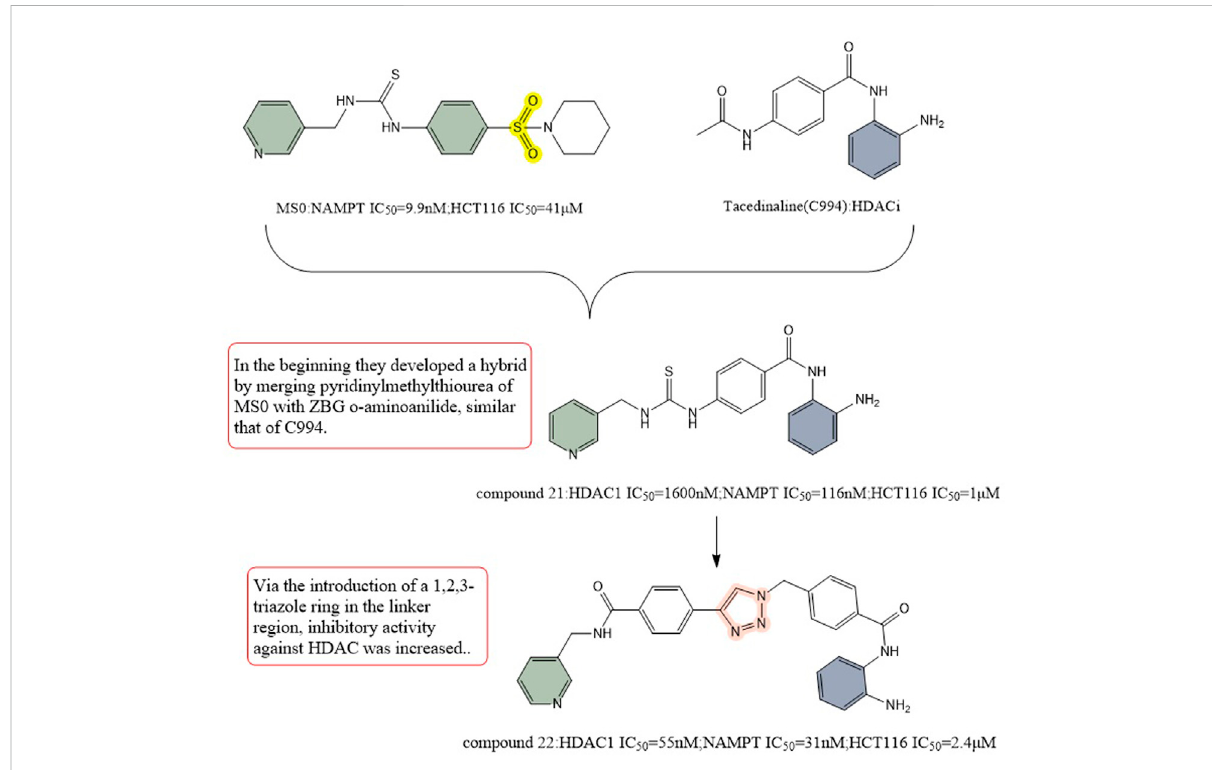
FIGURE 12 Structure design of HDAC and NAMPT dual inhibitors in Dong ’ s